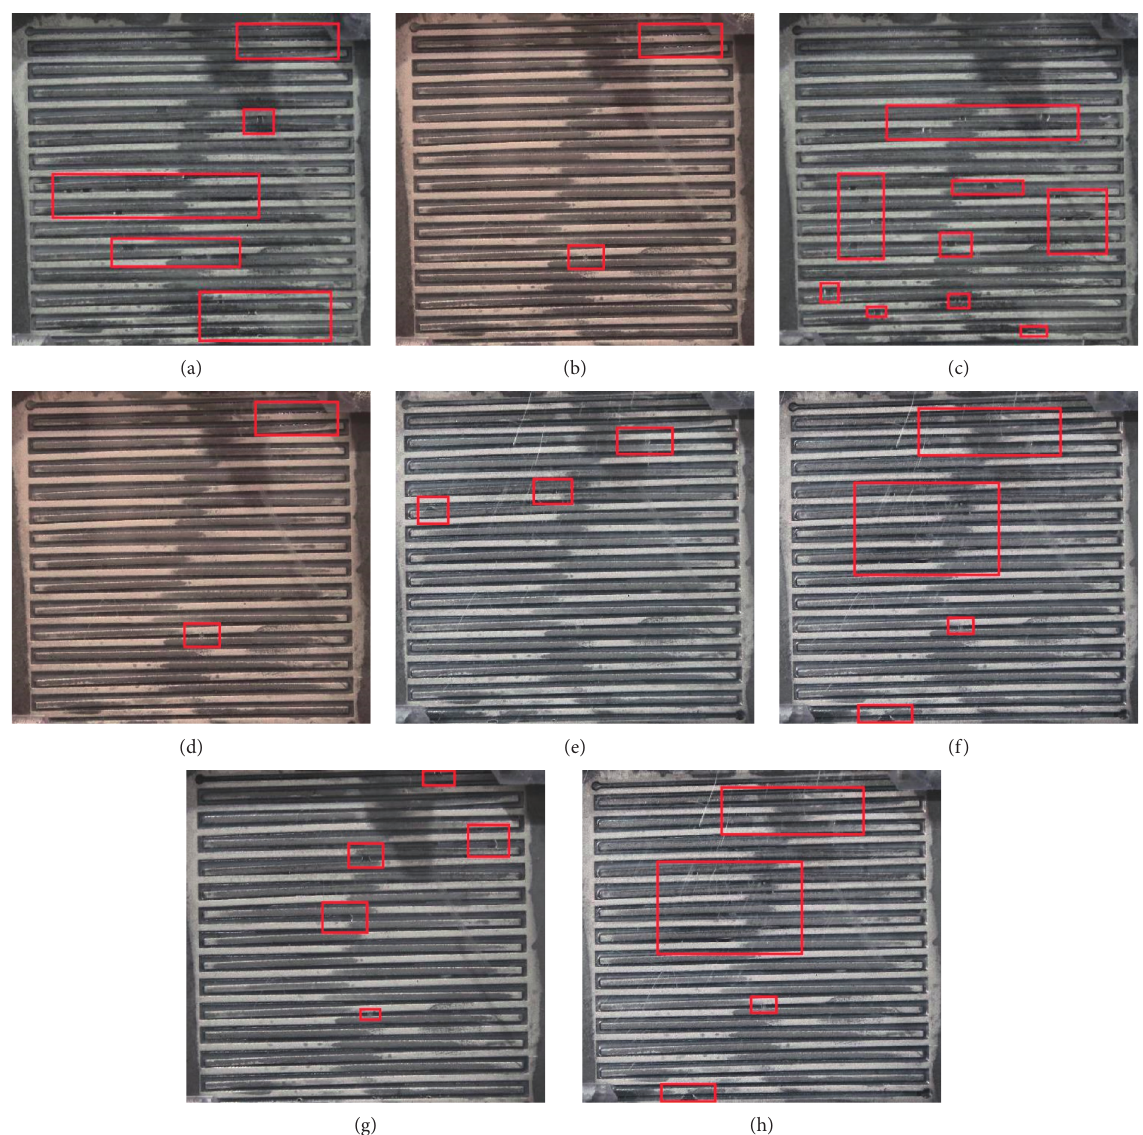
Figure 7: Water state in the fuel cell under different operation conditions at the same time. (a) Inlet gas temperature 45 ° C. (b) Inlet gas temperature 65 ° C. (c) Inlet gas humidity 20%. (d) Inlet gas humidity 80%. (e) Hydrogen stoichiometry 1.05. (f) Hydrogen stoichiometry 2.0. (g) Air stoichiometry 2.0. (h) Air stoichiometry